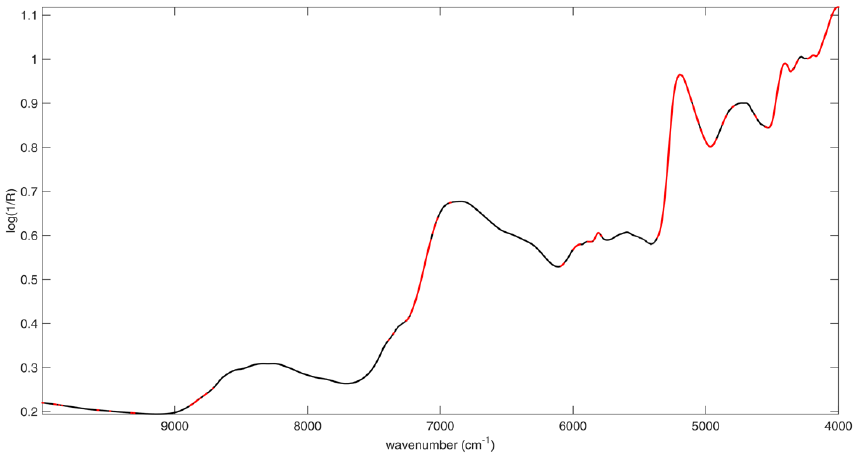
Figure A1. VIP Analysis: Mean spectrum (black line). Variables presenting a VIP index > 1 are highlighted in